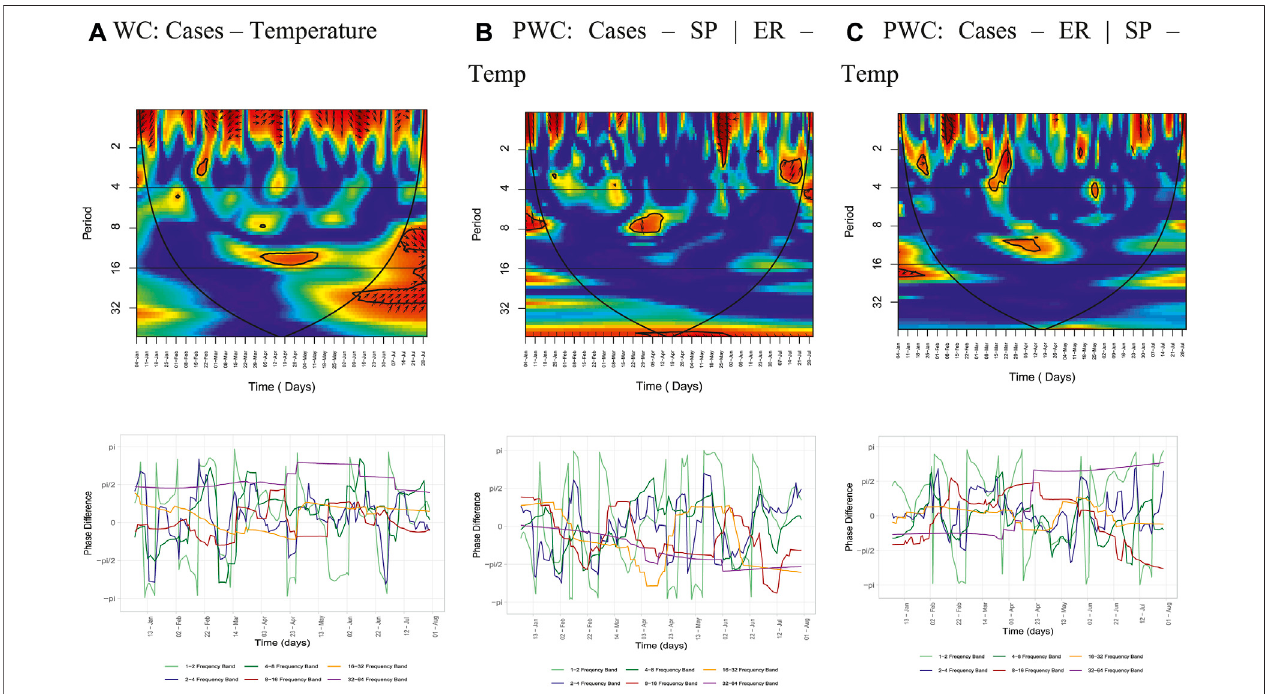
FIGURE 8 | United Kingdom (A) WC: Cases — Temperature. (B) PWC: Cases — SP | ER — Temp. (C) PWC: Cases — ER | SP — Temp.